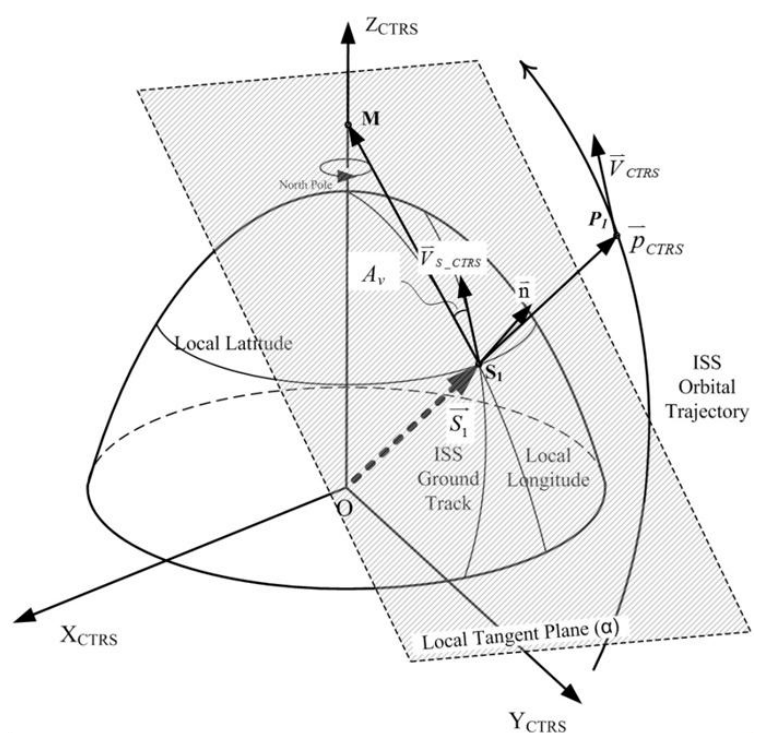
Figure 5. Illustration of the ISS orientation angle in local tangent plane in the Conventional Terrestrial Reference System (CTRS) coordinate system. is the S_CTRS projected ground speed of the ISS velocity ( ). is the normal of the local tangent CTRS plane ( α ) at point S . M is the intersection of Z-axes ( Z ) and the local tangent plane. 1 CTRS The angle formed by and is the ISS orientation angle ( A S_CTRS v